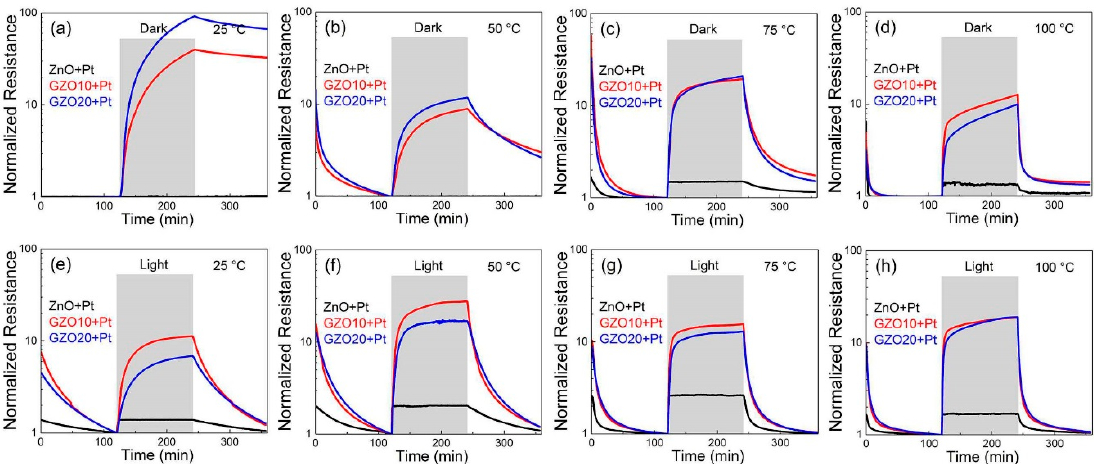
Figure 2. Chemoresistive gas sensing properties of ZnO and GZO film with 10 and 20% Ga doped with Pt NPs. Normalized resistance changes to 400 ppb NO 2 exposure (gray shaded box) at different operating temperatures (25 °C–100 °C) under dark ( a – d ) and purple − blue light irradiation ( e – h )